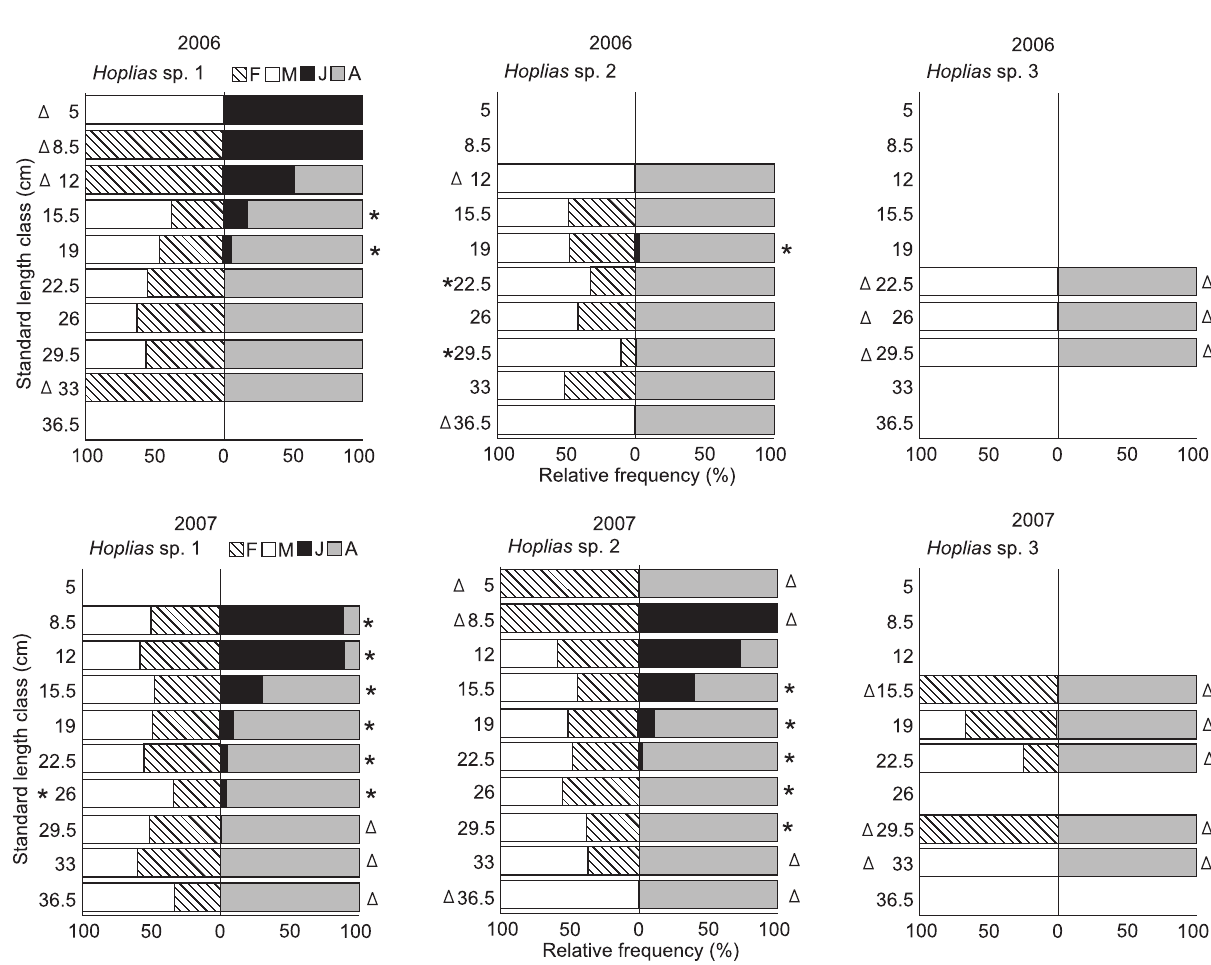
Figure 5. Relative frequency of males (M) and females (F) and juveniles (J) and adults (A) of Hoplias sp. 1, Hoplias sp. 2 and Hoplias sp. 3 for standard length class (cm) in the Upper Paraná River floodplain in 2006 and 2007. * significant at the level of 5%; (cid:2) = impossible to calculate